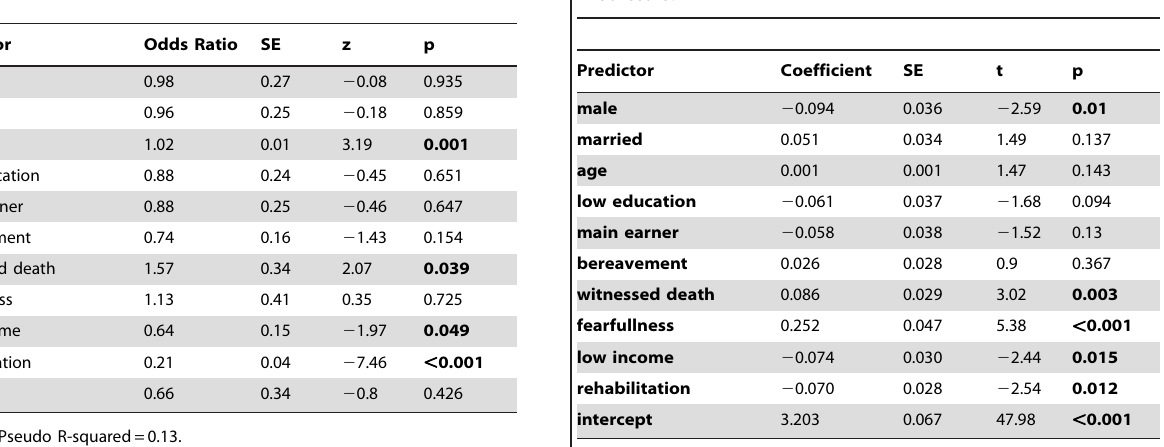
Table 3. Ordinary Least Squares Regression of Post-traumatic Stress Symptoms (PCLC, log-transformed) on Selected Predictors.